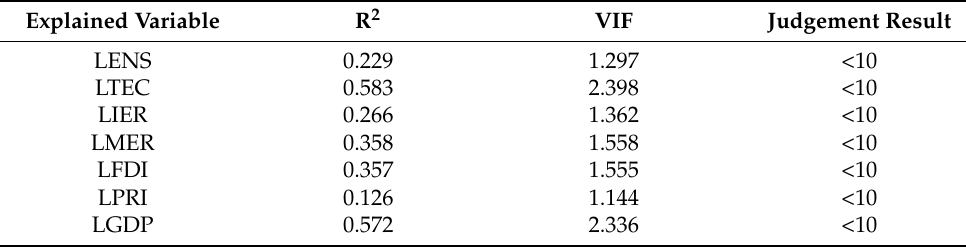
Table 5. Results of the variance inflation factor